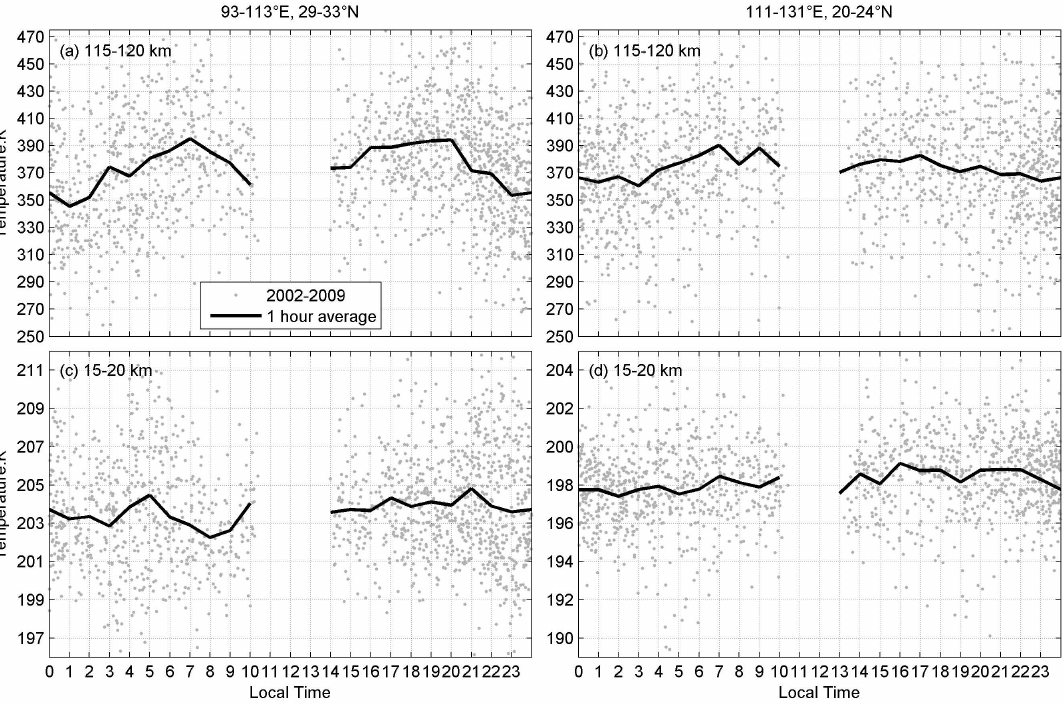
Fig. 1. The diurnal variation of Tn around the epicenters of Wenchuan (left panels) and Pingtung Doublet (right panels) earthquakes during 2002–2009. Gray points are individual Tn measurements at two height regions of 115–120km (upper panels) and 15–20km (lower panels). The solid dark lines denote the hourly average. Observations were not available during 10:00 to